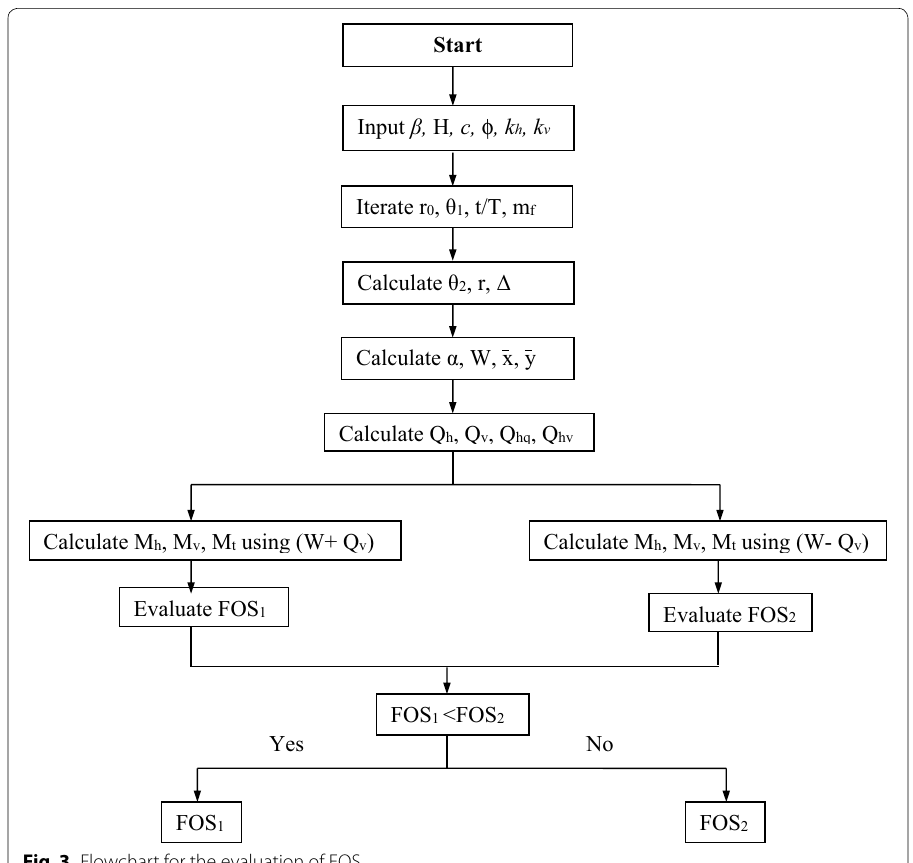
Fig. 3 Flowchart for the evaluation of FOS